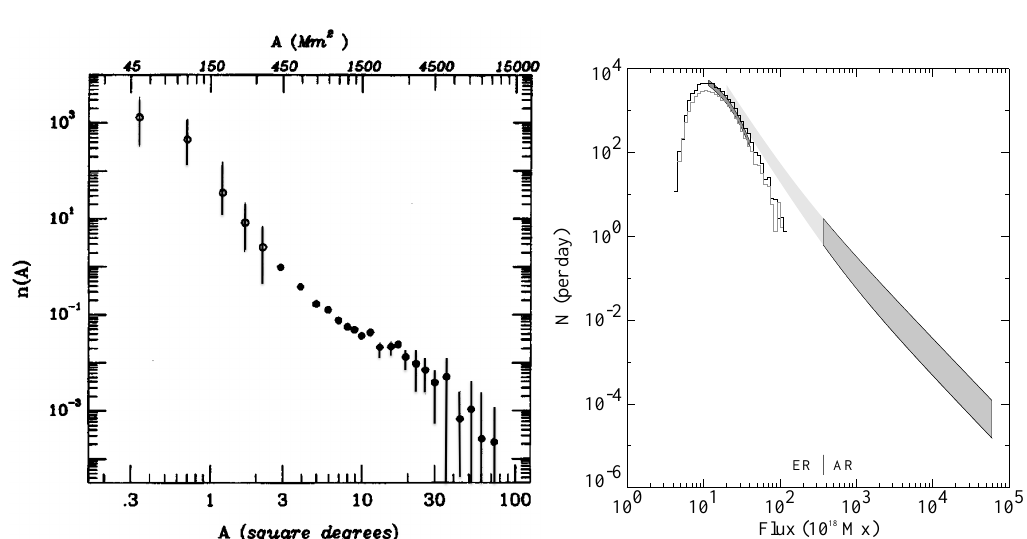
Figure 3: Left: Cycle-averaged area distribution ( 𝑛 ( 𝐴 )) of bipolar regions at maximum development. The numbers are corrected for incompleteness in the counts and are normalised to a number density per day and per square degree ( ≈ 150 Mm 2 ). These results are based on 978 ARs (dots) and 9492 ERs (circles). The vertical bars on the latter indicate uncertainties arising from their short lifetime and low sampling rate. Error bars on AR numbers indicate uncertainties arising from statistics of small samples. Image reproduced with permission from Zwaan and Harvey (1994), copyright by CUP. Right: Hagenaar et al. (2003) combined the distribution functions of ARs (defined as regions larger than 2 . 5 deg 2 taken from Harvey (1993), cf. left panel) with that of ephemeral regions (ERs) converting area to magnetic flux and applying flux scaling for different instruments. The plot shows flux emerging on the Sun per day, per flux interval of 10 18 Mx. The distribution for active regions varies by about a factor of 8 through a typical cycle; the extremes of that variation bound the dark shaded area on the right. The much smaller variation for the smallest ephemeral regions, shown by the darkest shading is likely weakly in anti-phase with the sunspot cycle; full histograms are shown for 1997 October (black) and 2000 August (grey). The turnover below 10 19 Mx likely reflects the detection threshold of SOHO/MDI. The lightly shaded area between the smallest ephemeral regions and the active regions is an approximation due to lack of proper coverage. Image reproduced with permission from Hagenaar et al. (2003), copyright by